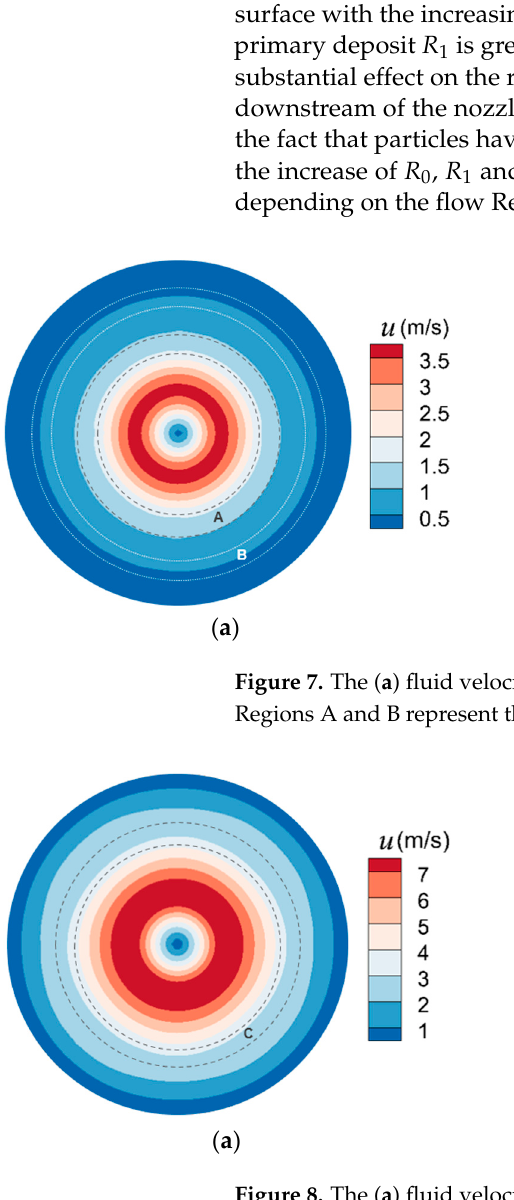
Figure 6. The schematic of particle trajectory above the impaction plate for “ring”.